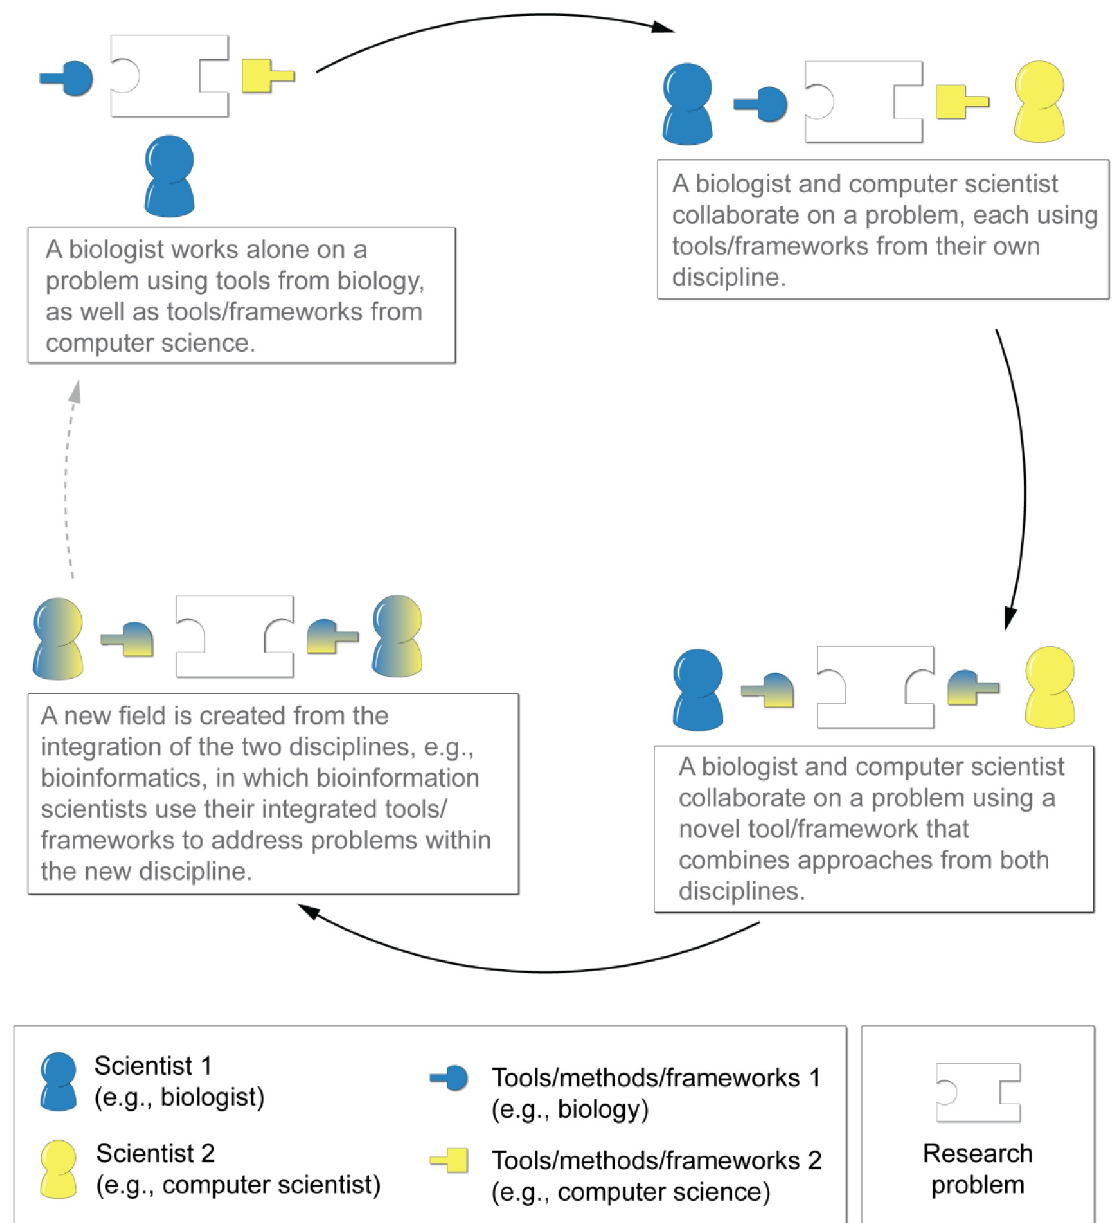
Fig 1. The spectrum of interdisciplinarity. Note . The dashed arrow represents the cycle beginning again. For example, with the field of bioinformatics, a bioinformaticist incorporates tools/frameworks from another outside discipline.